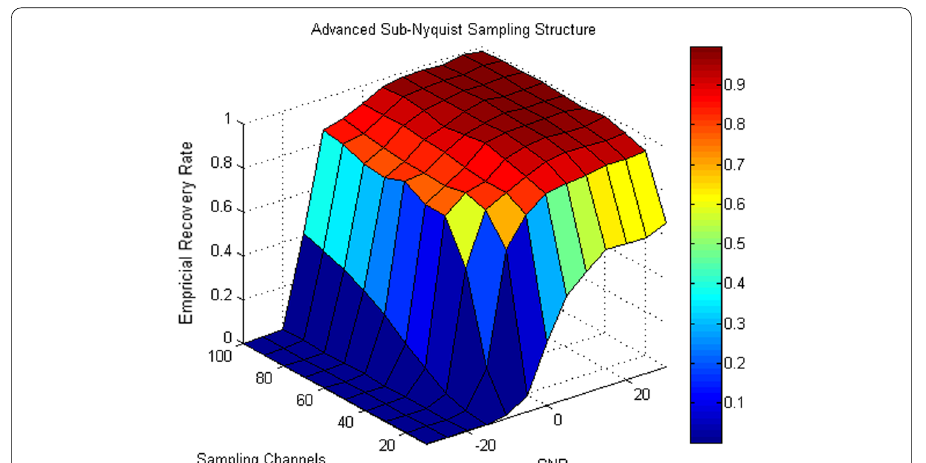
Fig. 8 Support set detection performance in ADS